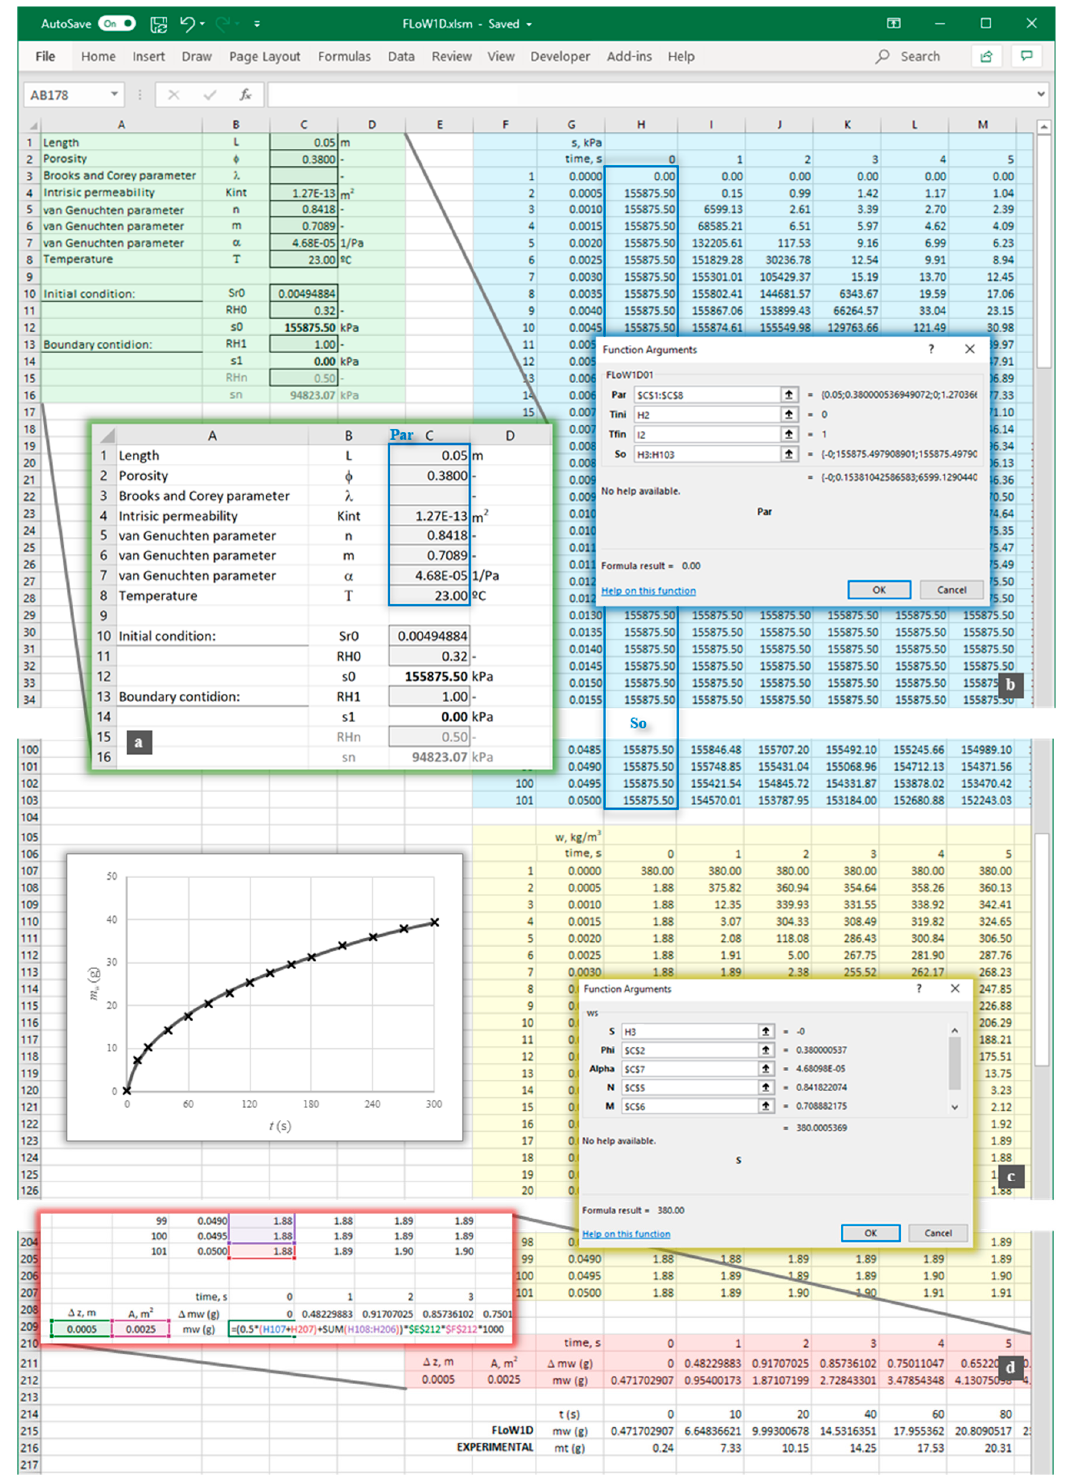
Figure 2. FLoW1D (One-Dimensional Water Flow) interface. ( a ) Input data. ( b ) FLoW1D function. ( c ) Water content function. ( d ) Total water content.